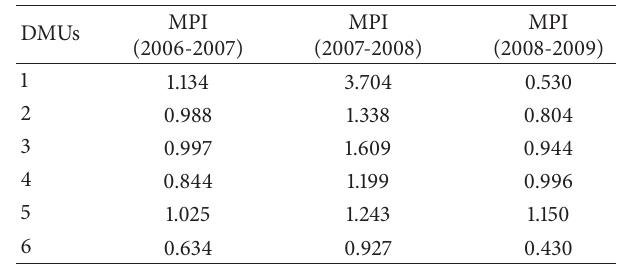
Table 7: Malmquist index comparison of 2008 to 2007.